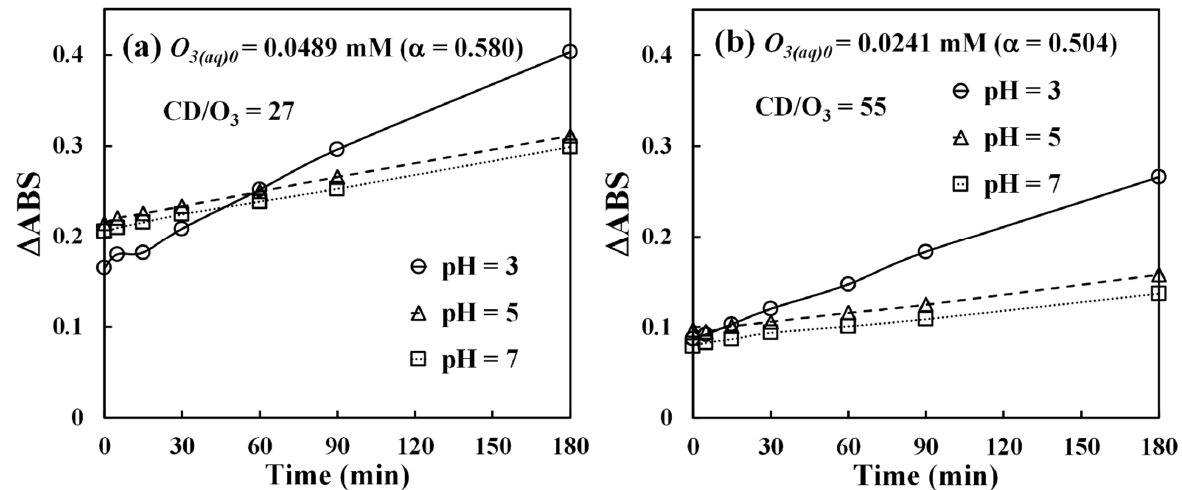
Figure 5. Dissolved ozone release rates as a function of CD/O 3 molar ratios at two different ozone loading rates at pH 3: α = 0.580; α = 0.504.